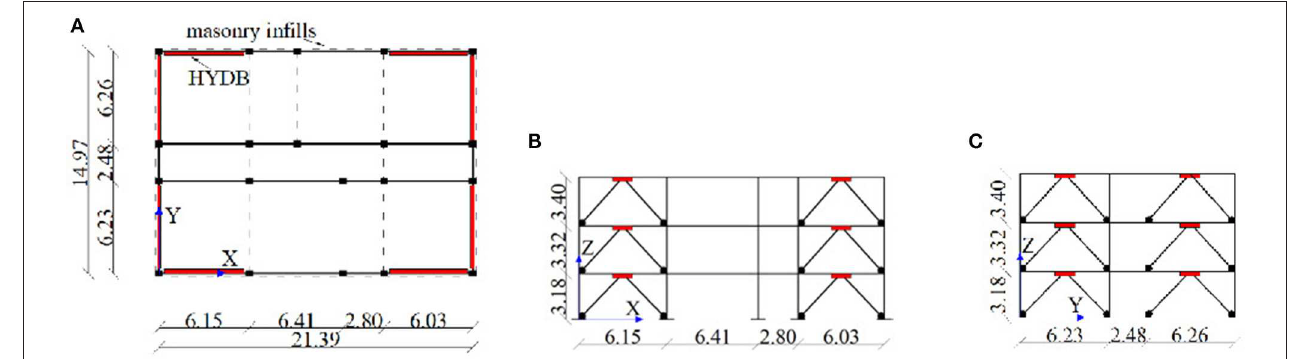
FIGURE 10 | Retrofitted Collina-Castello school in Bisignano (units in m). (A) Plan. (B) Longitudinal perimeter frame. (C) Transversal perimeter frame.